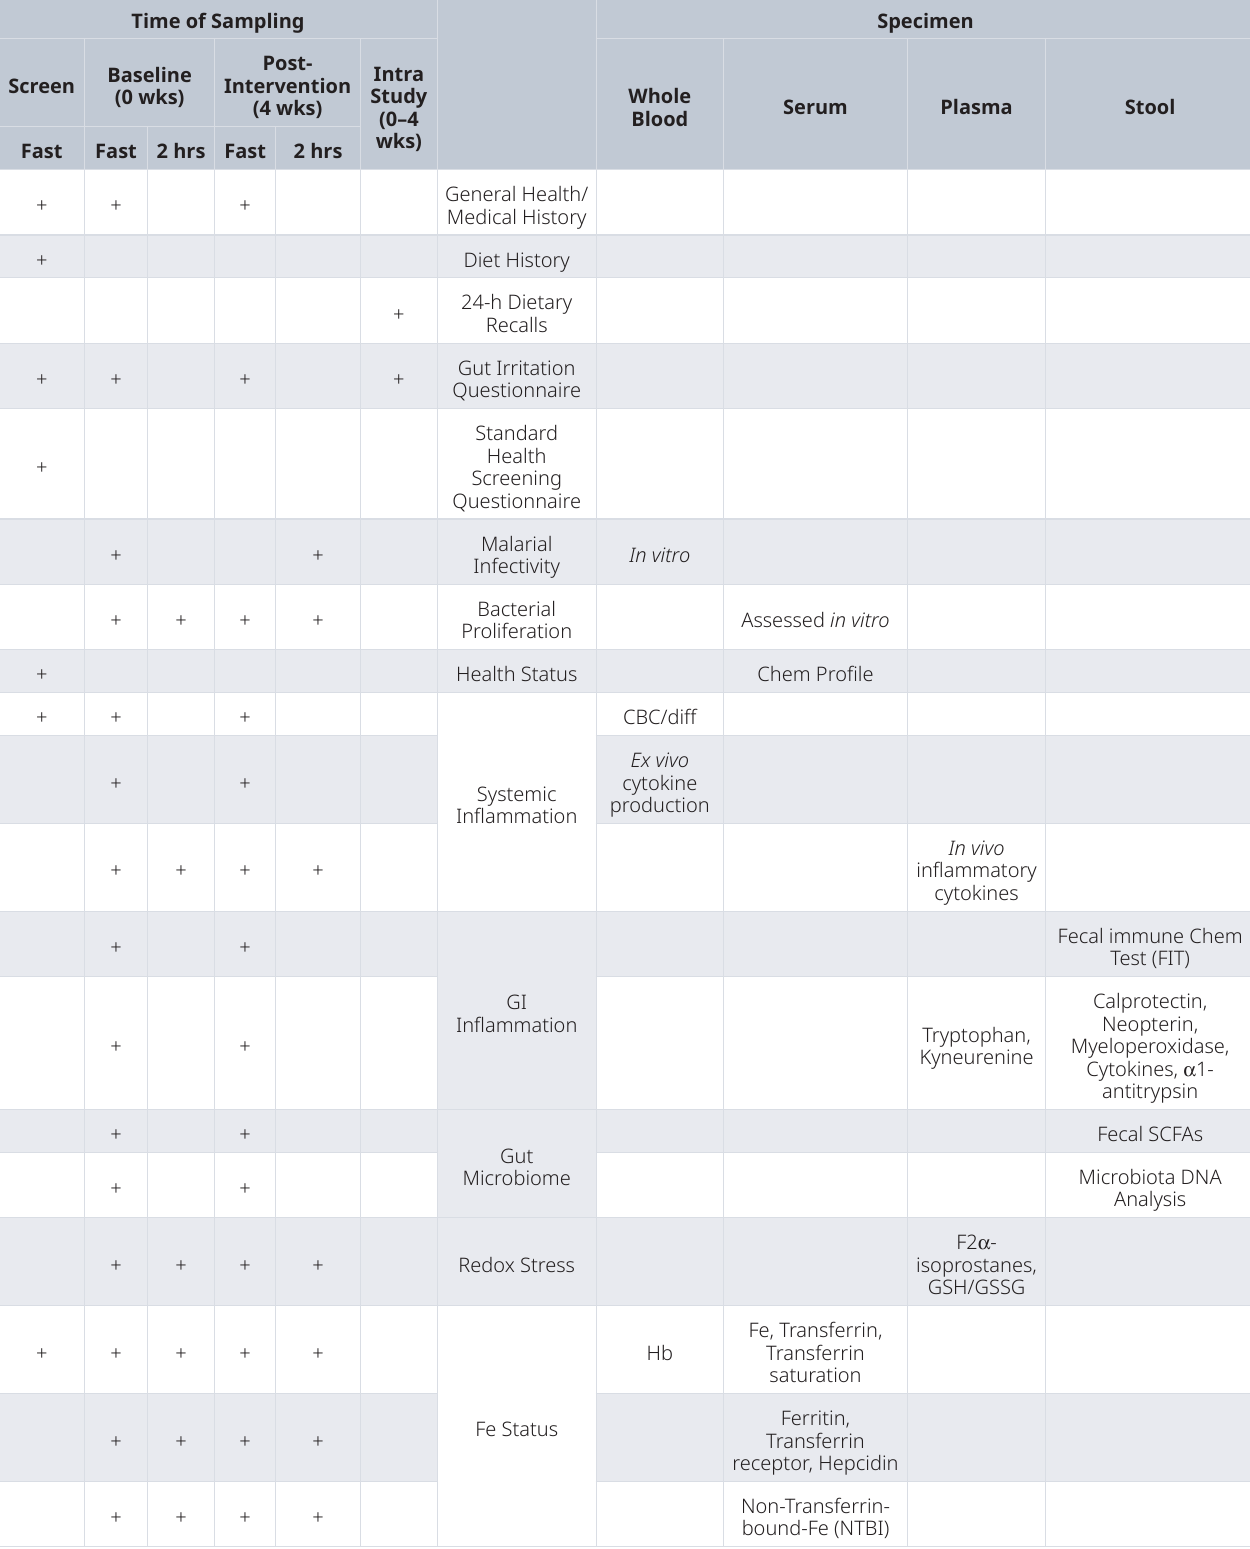
Table 3. Timing and analytical details of questionnaires, biological and chemical analyses conducted at each study visit. Time of